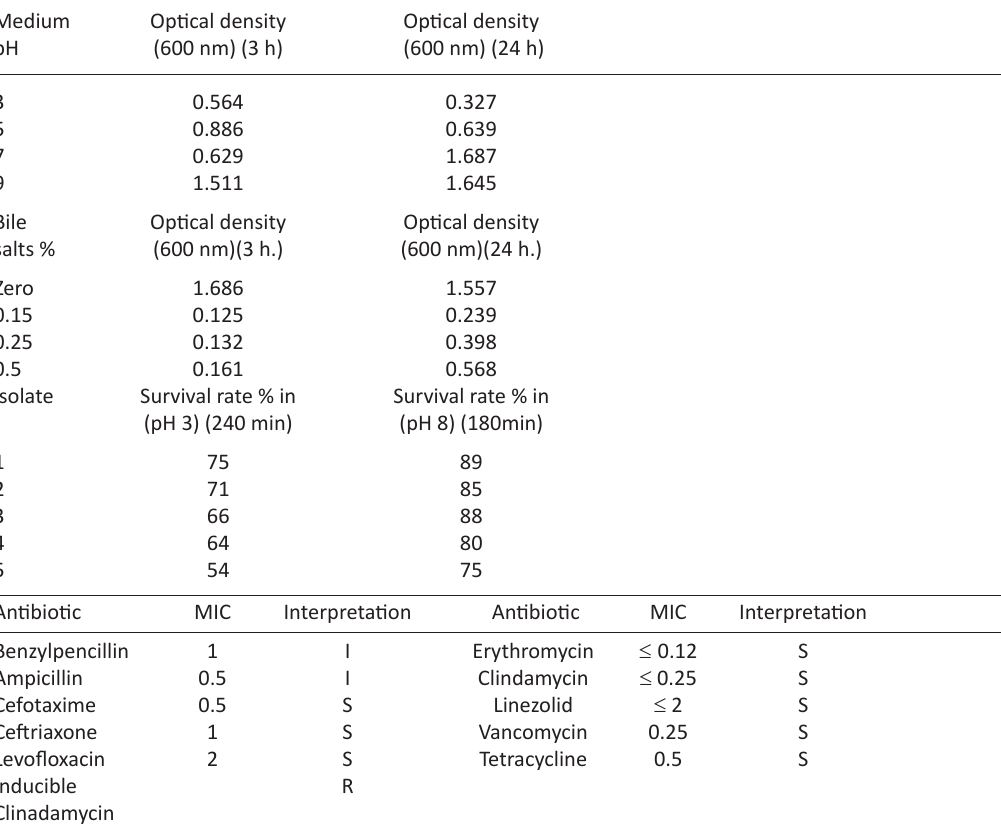
Table 3. The effects of both pH and concentration of bile salts on the survival of Pediococcus pentosaceus , the number of bacteria in gastric and intestinal juices, and the antibiotic sensitivity pattern of various antibiotics